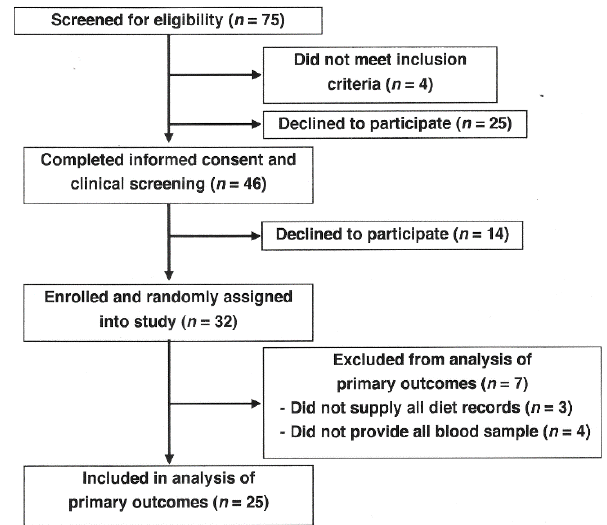
Figure 1. Recruitment flow diagram.